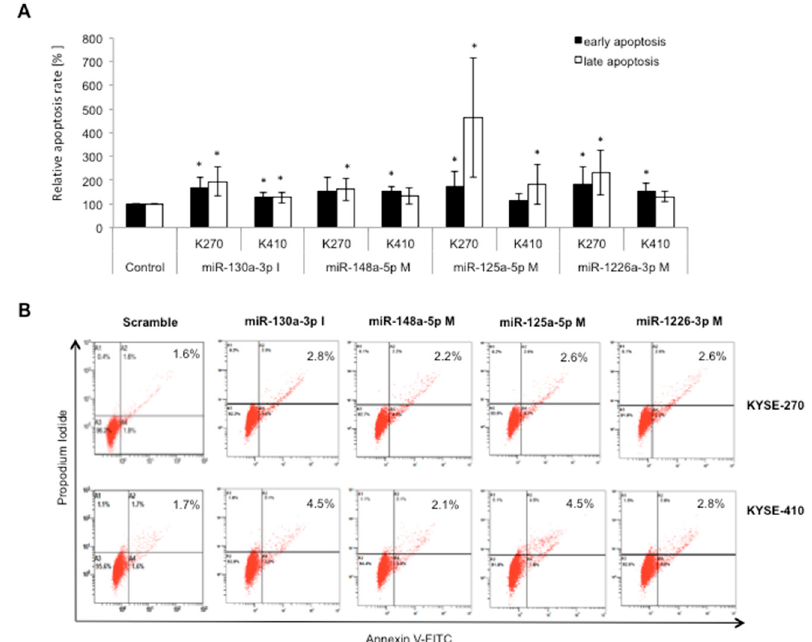
Figure 4. Specific miRNA signatures of resistant cell lines impact on apoptosis in ESCC. ( A ) Relative apoptosis rate of transfected cells vs. negative controls; ( B ) representative dot plot of the Annexin V-FITC and PI assay on ESCC cells treated with 20 ppmol of different miRNAs after 48 h of